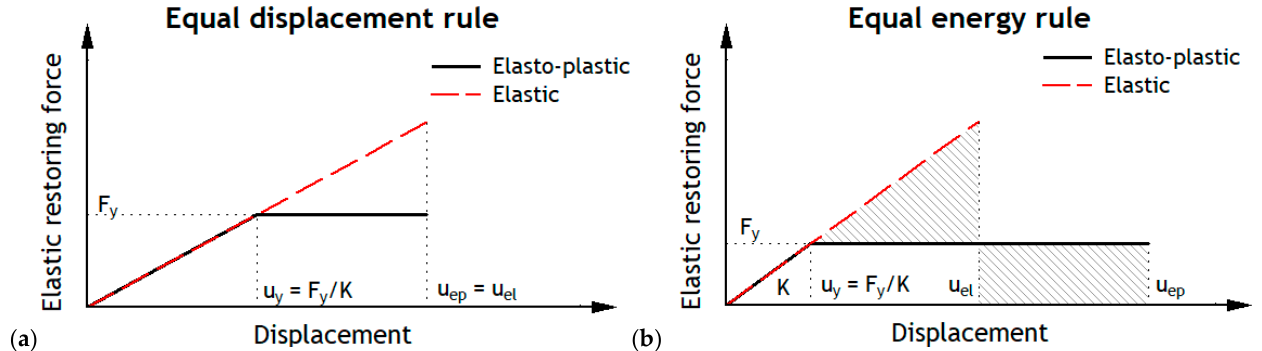
Figure 1. Well-known ( a ) equal displacement and ( b ) equal energy empirical rules relating the peak displacements of elastic and inelastic SDOF oscillators .